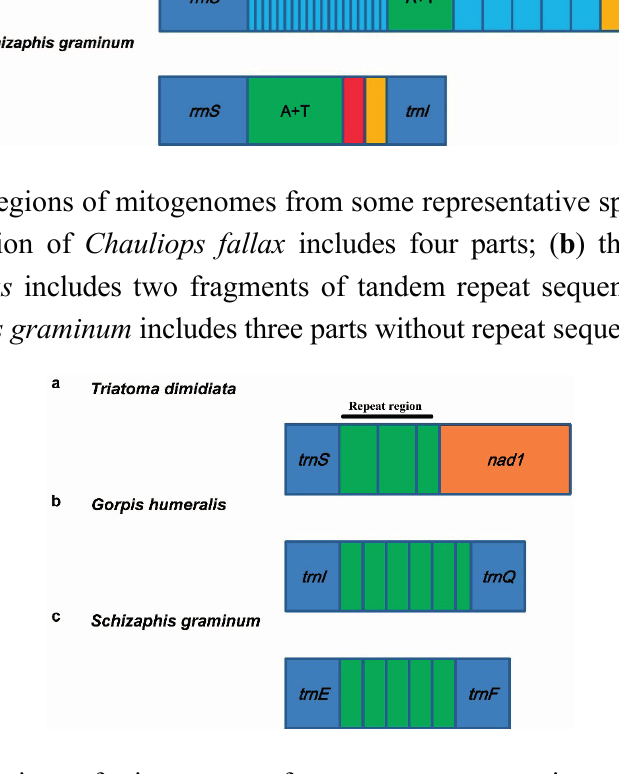
Figure 6. Repeat regions of mitogenomes from some representative species of Hemiptera. ( a ) the repeat region of Triatoma dimidiata (Hemiptera: Heteroptera: Reduviidae); ( b ) the repeat region of Gorpis humeralis (Hemiptera: Heteroptera: Nabidae); ( c ) the repeat region of Schizaphis graminum (Hemiptera: Sternorrhyncha: